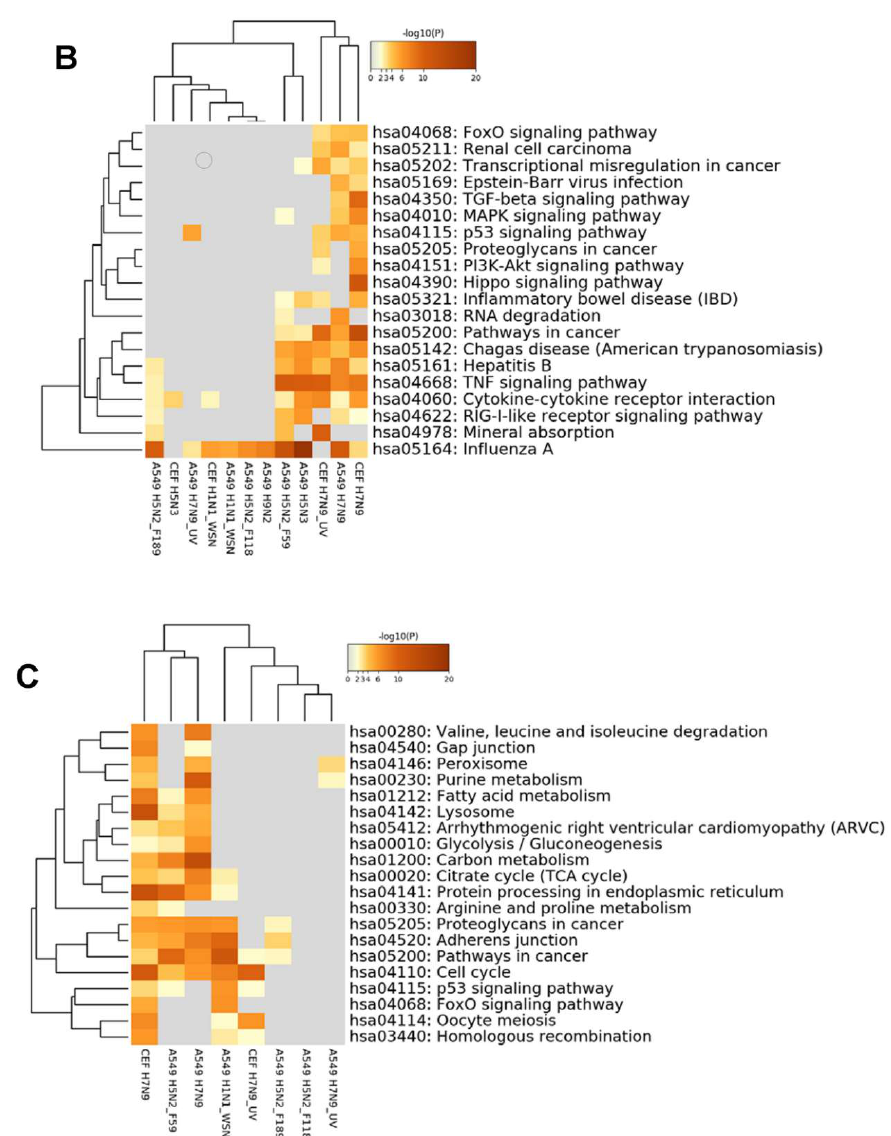
Figure 6. Comparison of orthologous di ff erentially expressed genes for CEF and A549 cells with di ff erent influenza A virus subtypes. ( A ) A heat map representing hierarchical clustering of up-regulated and down-regulated DEGs. ( B ) and ( C ) Comparison of the KEGG pathways of the ( B ) up-regulated and ( C ) down-regulated genes.